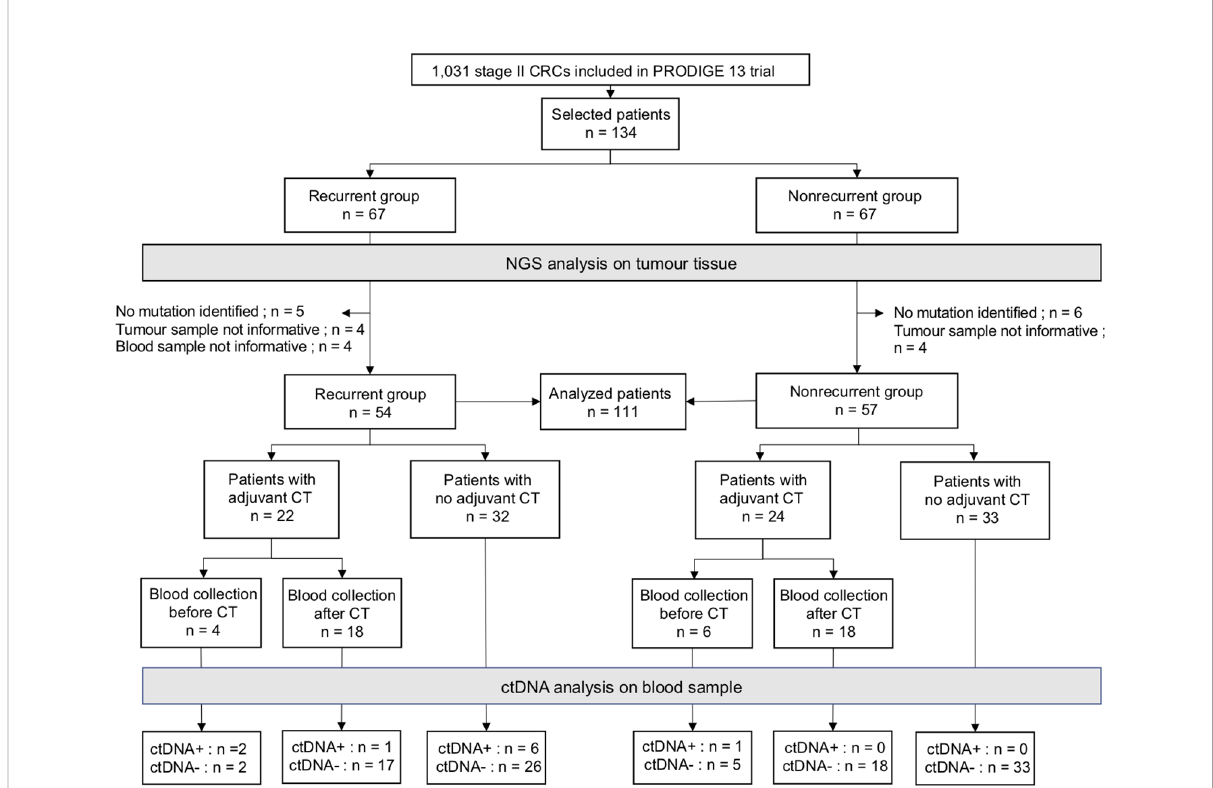
FIGURE 1 Flow chart of the study population. The overall population consisted of 134 patients with 67 in recurrent and matched nonrecurrent patients. The analysis of ctDNA was based on DNA somatic alterations from tumors detected using two successive NGS panels. At least one alteration was detected in 79/113 patients using the fi rst NGS and in 36/55 remaining patients with the second NGS panel. A total of 115/134 tumors were identi fi ed with at least one alteration, corresponding to 58 and 57 patients in the recurrent and nonrecurrent group, respectively. For each patient, ctDNA detection was performed using ddPCR analysis targeting alterations identi fi ed with NGS. Timing of blood sample collection was also indicated according to chemotherapy initiation if chemotherapy was used. CRCs, colorectal cancers; CT, chemotherapy; ctDNA, circulating tumor